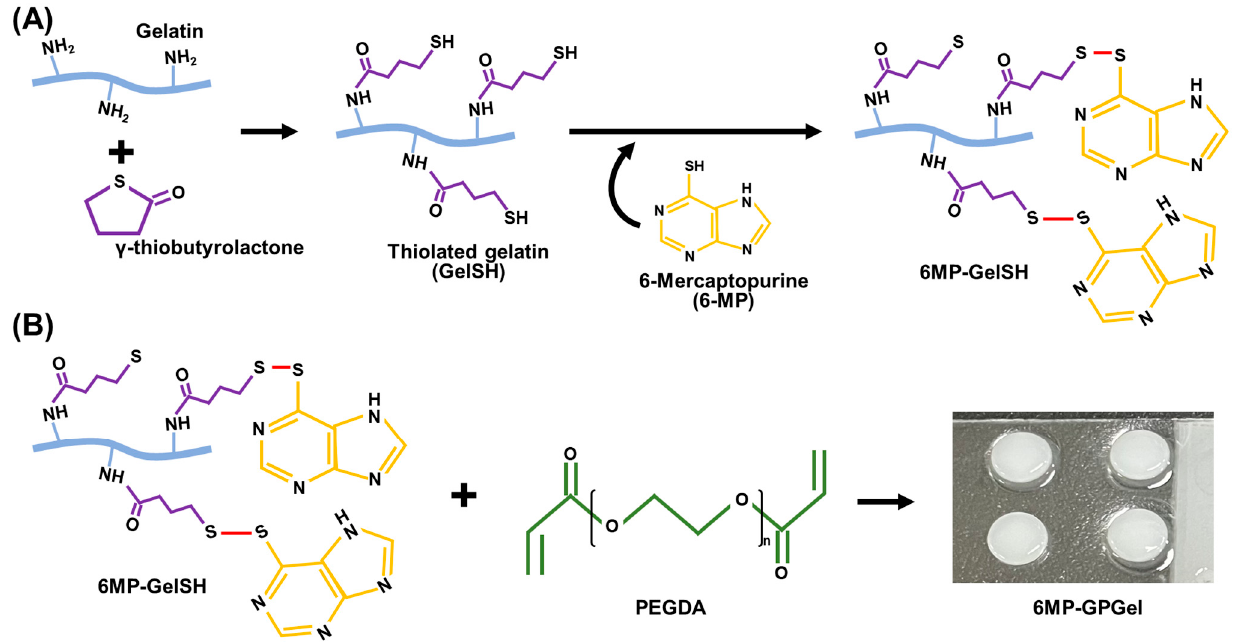
Figure 1. A schematic illustration of ( A ) the synthesis of thiolated gelatin and disulfide bond-mediated 6-MP conjugation, and ( B ), the fabrication of 6MP-GPGel.